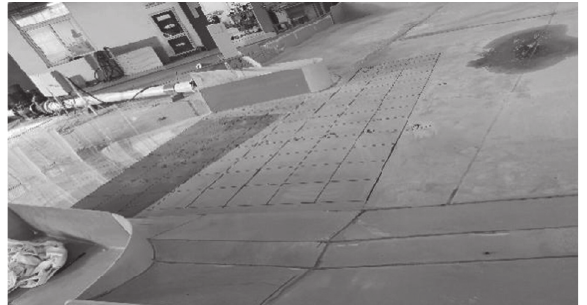
Figure 3: Physical model test device.